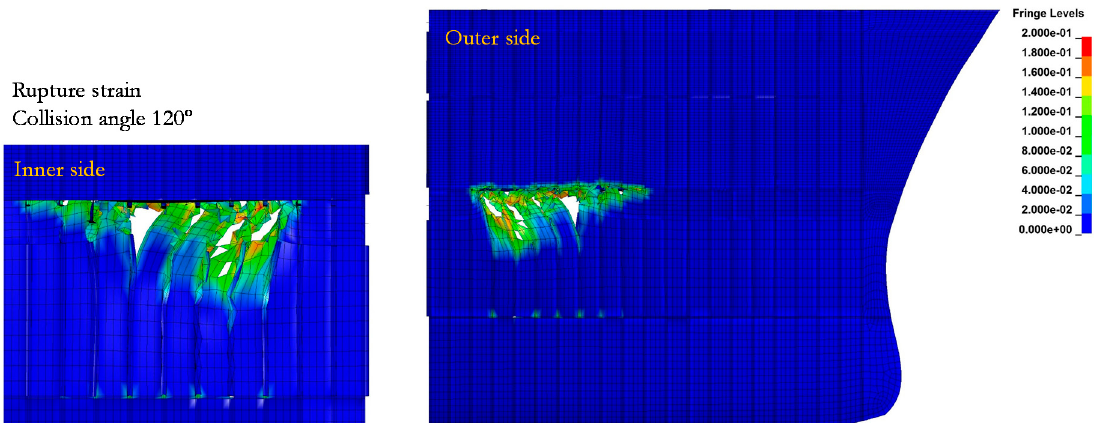
Figure 11. Contours of the strain near the car deck: Angle 120°.